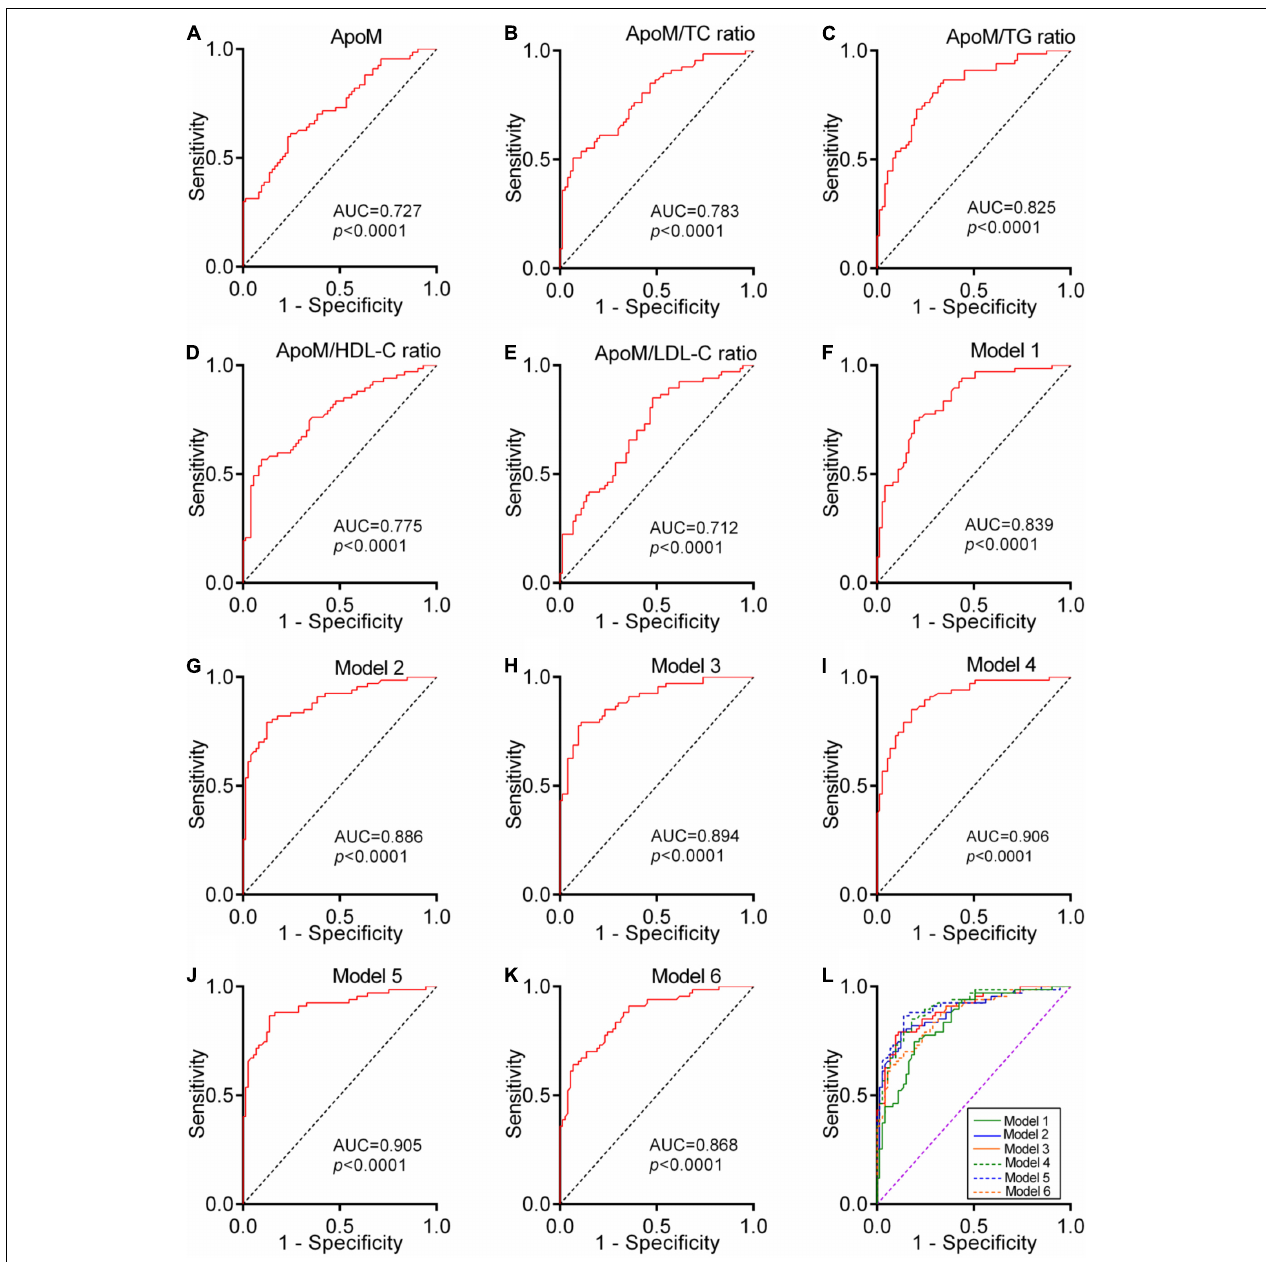
FIGURE 6 | Diagnostic power of plasma ApoM and its derived indicators for AD. ROC analyses of ApoM (A) , ApoM/TC ratio (B) , ApoM/TG ratio (C) , ApoM/HDL-C ratio (D) and ApoM/LDL-C ratio (E) . Model 1: age, sex, APOE ε 4, and BMI (F) . Model 2: age, sex, APOE ε 4, BMI, and ApoM (G) . Model 3: age, sex, APOE ε 4, BMI, and ApoM/TC ratio (H) . Model 4: age, sex, APOE ε 4, BMI, and ApoM/TG ratio (I) . Model 5: age, sex, APOE ε 4, BMI, and ApoM/HDL-C ratio (J) . Model 6: age, sex, APOE ε 4, BMI, and ApoM/LDL-C ratio (K) . Comparison of ROC-AUCs of all the models using DeLong’s test (L) . ApoM, apolipoprotein M; AD, Alzheimer’s disease; TC, total cholesterol; TG, triglyceride; HDL-C, high-density lipoprotein cholesterol; LDL-C, low-density lipoprotein cholesterol, BMI, body mass index; APOE, apolipoprotein E; ROC, receiver operating characteristic; AUC, area under the curve. p < 0.05 was considered the statistical significance.